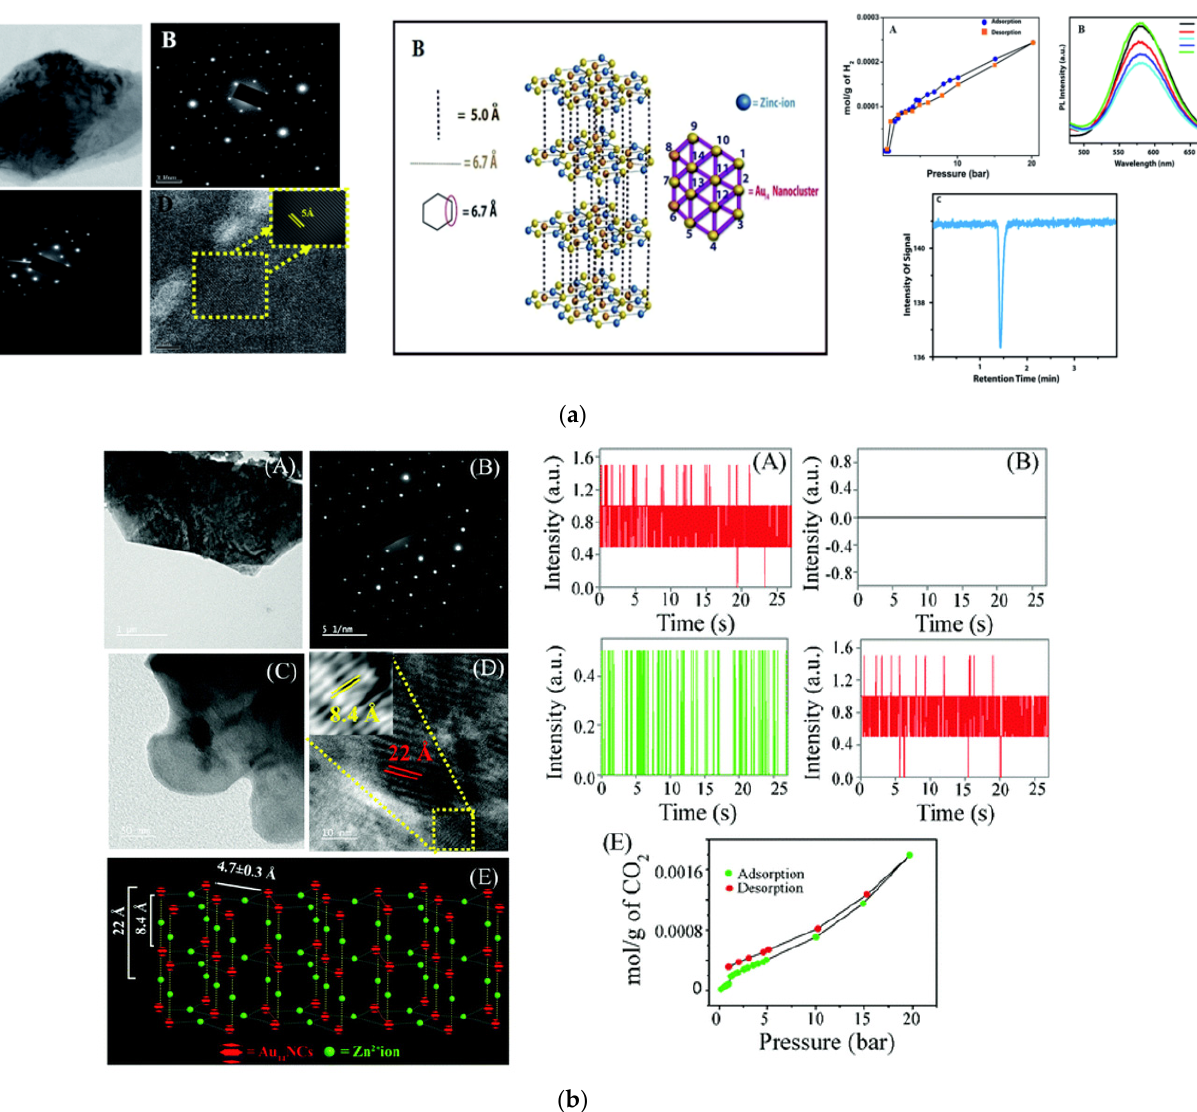
Figure 6. ( a ) Experimental results showing formation zinc mediated three-dimensional crystalline assembly of Au NCs stabilized by MPA and histidine, and use of the assembly in storage and sensing of hydrogen at plaint conditions. Reprinted with permission from [90]. Copyright Royal Society of Chemistry 2016. ( b ) Experimental results showing formation zinc mediated three-dimensional crystalline assembly of Au NCs stabilized by MPA and cysteine, and use of the assembly in storage and sensing of carbon dioxide at a few particle level. Reprinted from Ref. [94] with permission. Copyright Royal Society of Chemistry 2018.